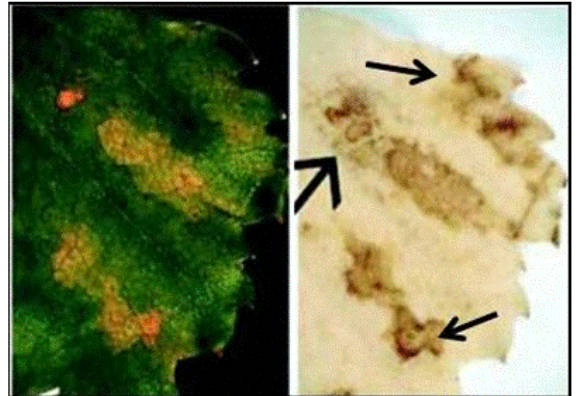
FIGURE 3. Accumulation of H 2 O 2 within ozone-exposed leaf tissue. Lesion development and H 2 O 2 accumulation in birch leaves. Taken and modified from Fig. 1[9]. Birch leaf with lesions 10 h after the beginning of an 8-h ozone (150 nl/l) exposure. Left, normal photograph; right, DAB staining reveals H 2 O 2 accumulation at and around lesion sites (arrows) in a cleared leaf 2 h